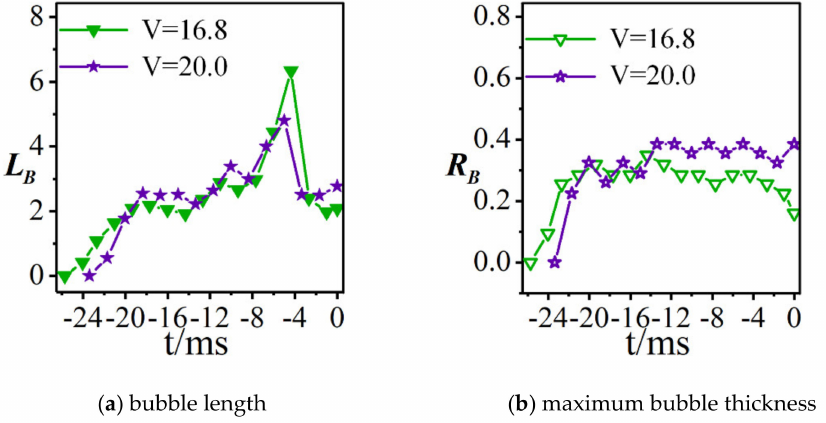
Figure 9. Variation curve of bubble sizes of 60 ◦ cone-head projectiles at 16.8 m/s and 20.0 m/s. ( a ) bubble length ( b ) maximum bubble